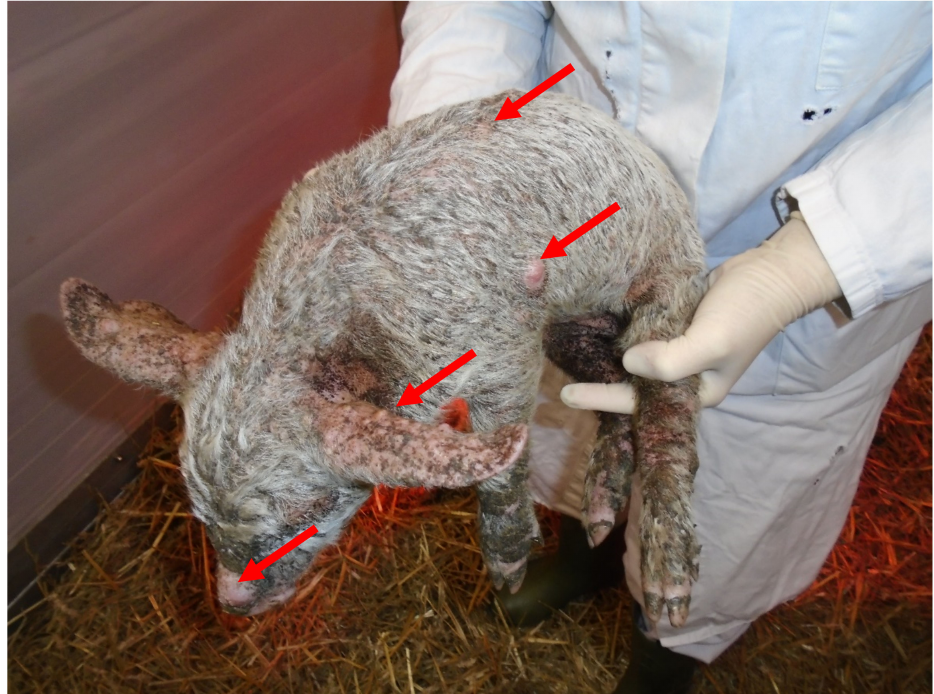
Figure 2. Piglet affected by exudative epidermitis and with multiple abscesses in the skin represented by red arrows.